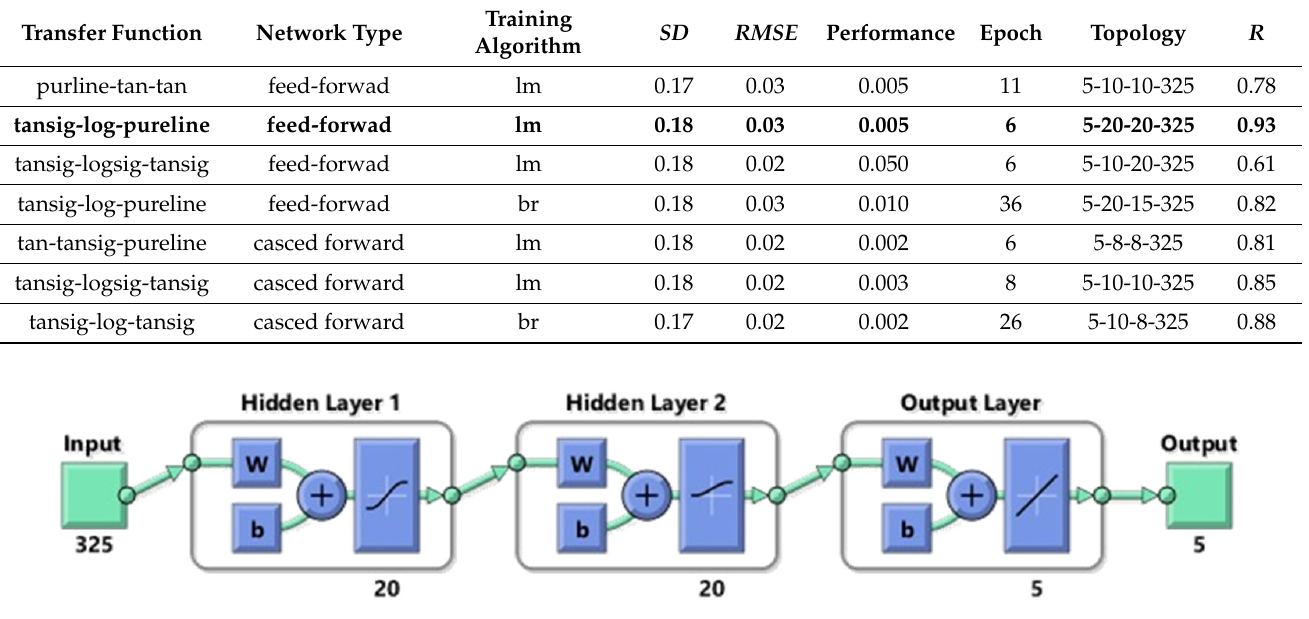
Table 7. Results of artificial neural network analysis for hyperspectral imaging.